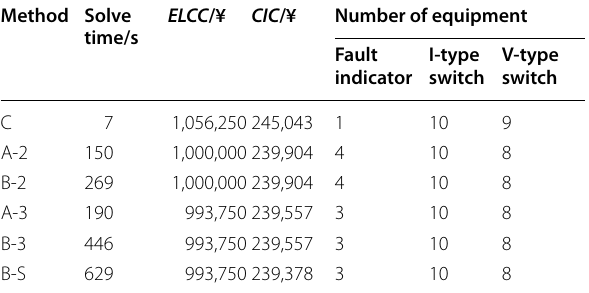
Table 10 Solution results when the failure probability of single equipment is 0.1